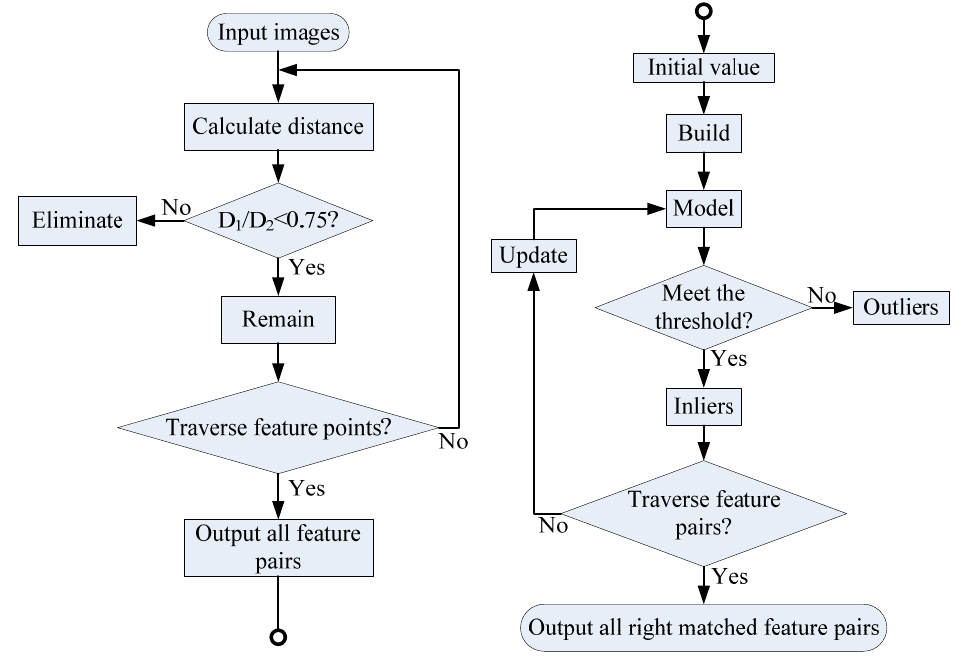
Figure 16. Matching flowchart.